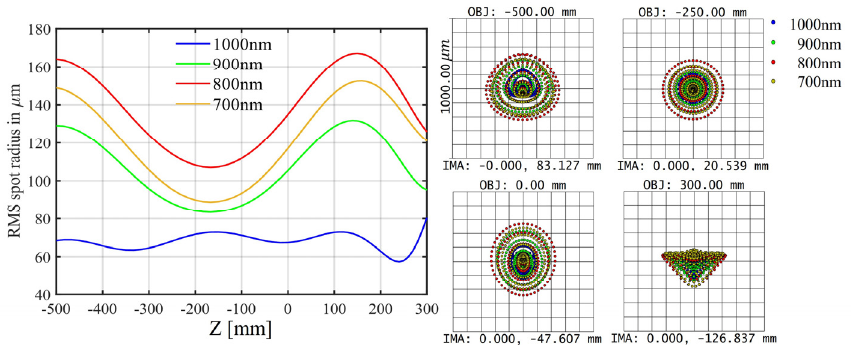
Figure 2. The RMS spot radius of images (IMA) versus Z value along the laser beam, and the spot diagram of the collection module for four objects (OBJ, i.e., TS measurement points).